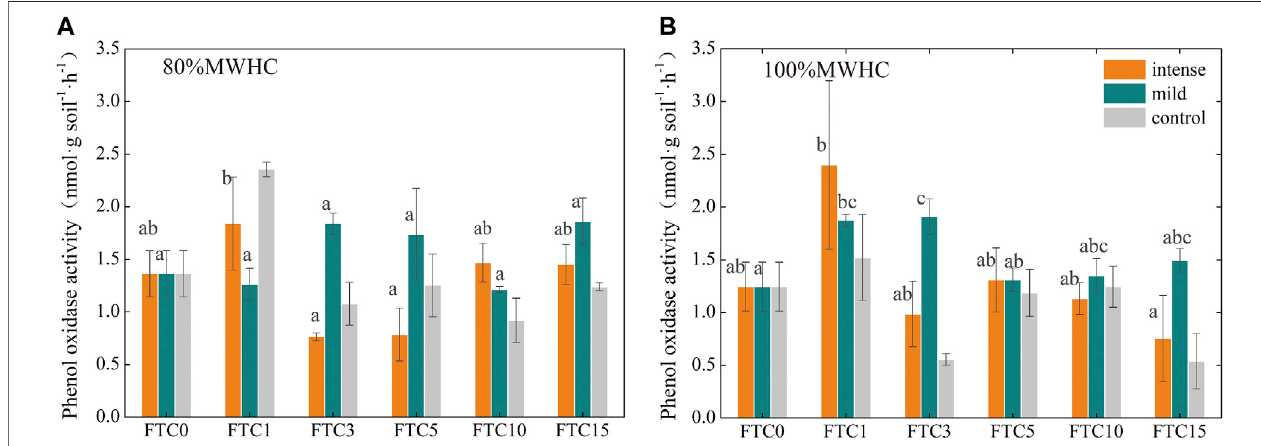
FIGURE 7 | Phenol oxidase activity changes during the freeze – thaw cycles. (A) The phenol oxidase activity of 80%MWHC peat; (B) the phenol oxidase activity of 100%MWHC peat. Mild means freeze – thaw cycle at − 5~4 ° C; intense means freeze – thaw cycle at − 15~4 ° C.